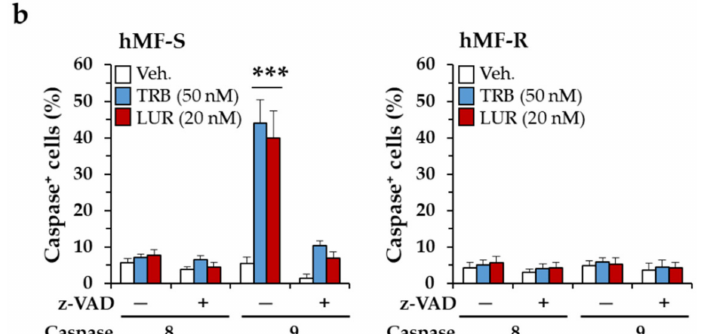
Figure 9. TRB and LUR administration promotes apoptosis in hMF-S cells. ( a ) hMF-S cells were treated with TBR and the protein levels of B-cell lymphoma 2 (Bcl-2), the cleavage of caspase 3, and the accumulation of the poly (ADP)-ribose polymerase 1 (PARP1) cleaved protein were determined by immunoblot at the indicated times; ( b ) hMF-S and hMF-R cells were treated with TRB (50 nM) and LUR (20 nM) and loaded with permeant caspase 8 and caspase 9 activity-sensitive fluorescence substrates, and their activity was determined by flow cytometry at 8 h. Results show the means + S.E.M. of 5 independent preparations of each type of cells. *** p < 0.005 vs. the vehicle (Veh.)